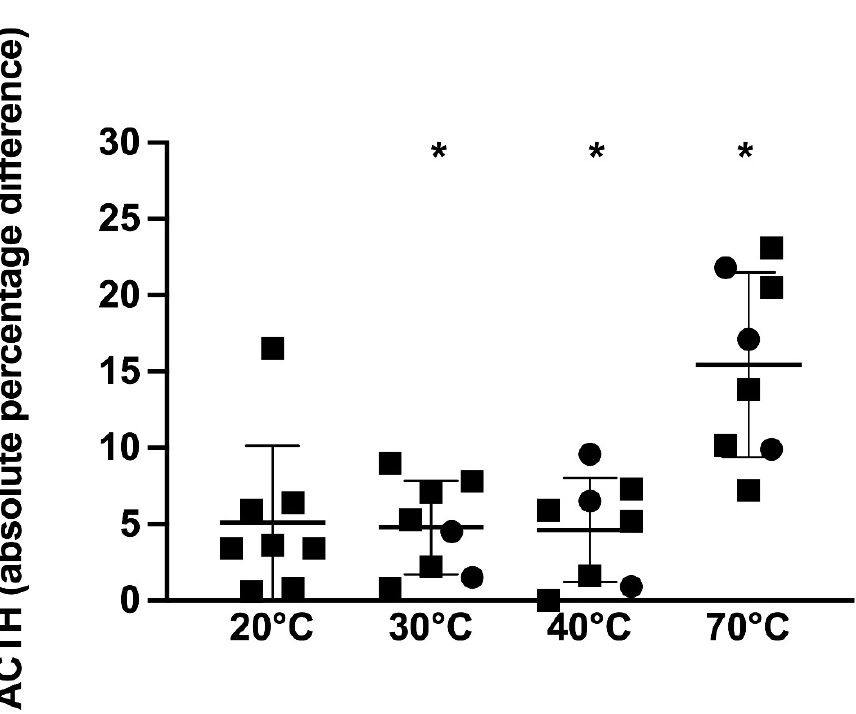
Figure 5. ACTH concentrations presented as the absolute percentage change from the reference sample in samples kept at 4 (reference sample), 20, 30, 40, and 70 °C in 8 PPID horses with solid shapes (mean ± standard deviation). Squares represent horses in which the basal ACTH concentration was determined and circles indicate horses in which the post-TRH stimulation ACTH concentration was determined. * p < 0.05 vs. 4 °C.